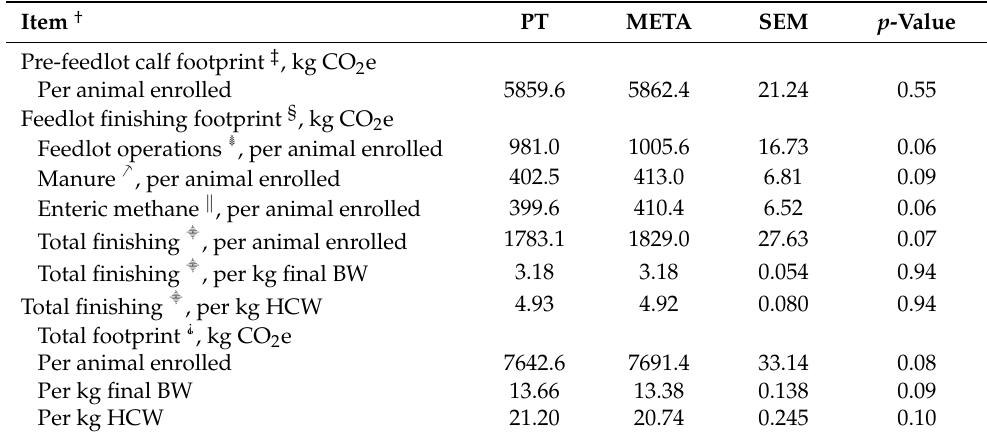
Table 5. Model adjusted means and standard errors of the mean (SEM) for economic outcomes from a partial budget assessment of steers and heifers at medium risk for bovine respiratory disease (BRD) that received metaphylaxis (META) or a pull-and-treat (PT) health program for BRD* †.